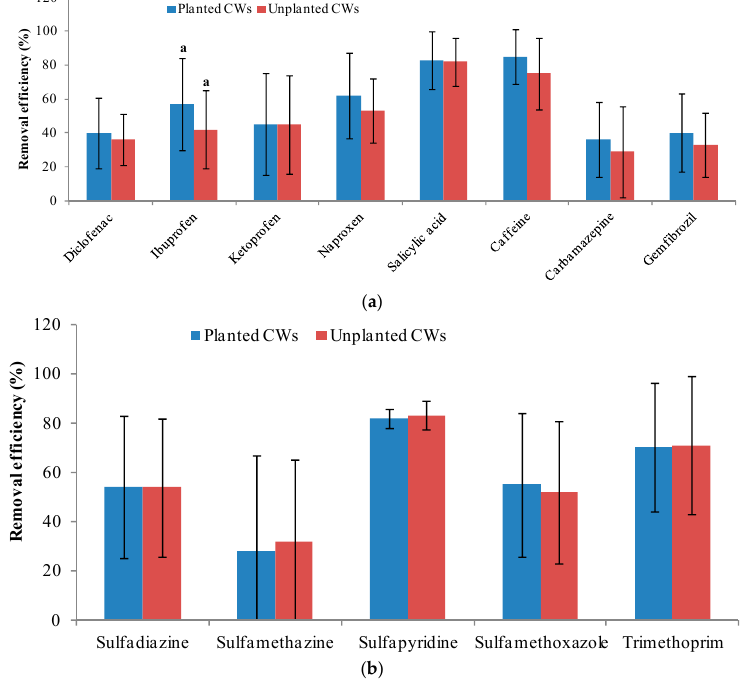
Figure 1. The removal efficiency (mean and standard deviation) of pharmaceuticals (PhCs) in planted and unplanted constructed wetlands (CWs). Note: ( a ) For ibuprofen, “ a ” shows the significant difference in the removal efficiency in planted and unplanted CWs at α = 0.05 ( p < 0.05). ( b ) The removal efficiency of studied PhCs in planted and unplanted CWs was not significantly different at α = 0.05 ( p < 0.05). The number of observations for studied PhCs in planted and unplanted CWs is given in Table S7 (Supplementary Materials). Negative values in the case of standard deviation were capped at zero to improve the readability of the graph. Actual values (e.g., below zero) can be found in Table S7 (Supplementary Materials).